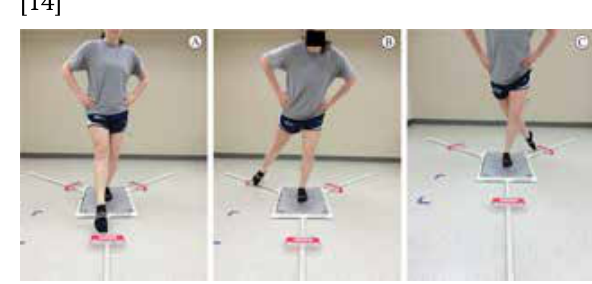
Figure 2. Y balance test.